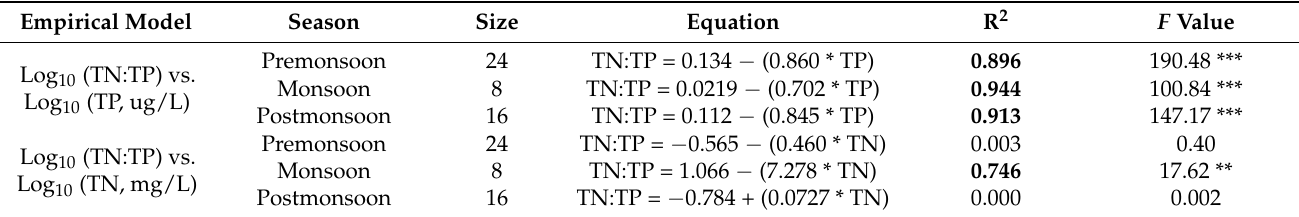
Table 4. The monsoon-seasonal responses of log-transformed TP and TN to Log 10 (TN:TP). Empirical